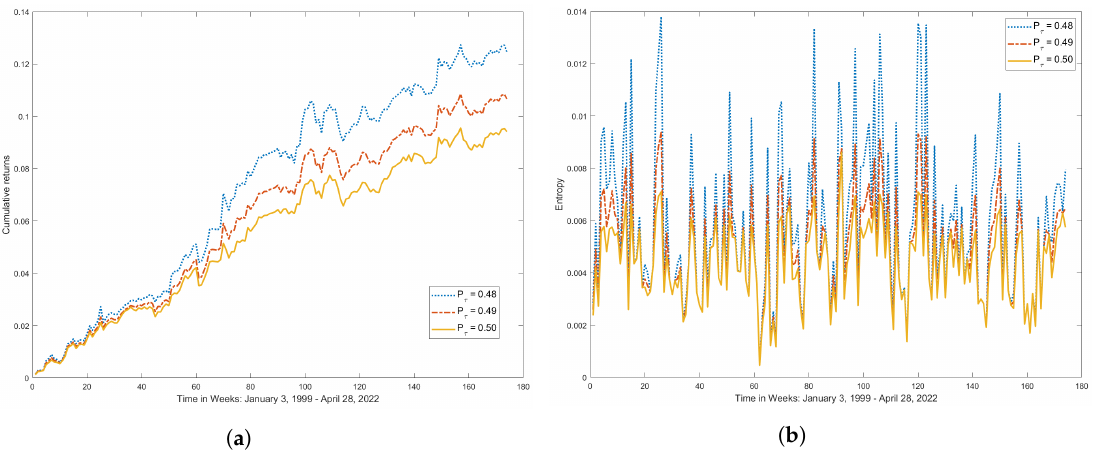
Figure 3. Portfolio Returns and Entropy by Shortfall Probability. ( a ) Cumulative returns by shortfall probability; ( b ) Entropy by Shortfall